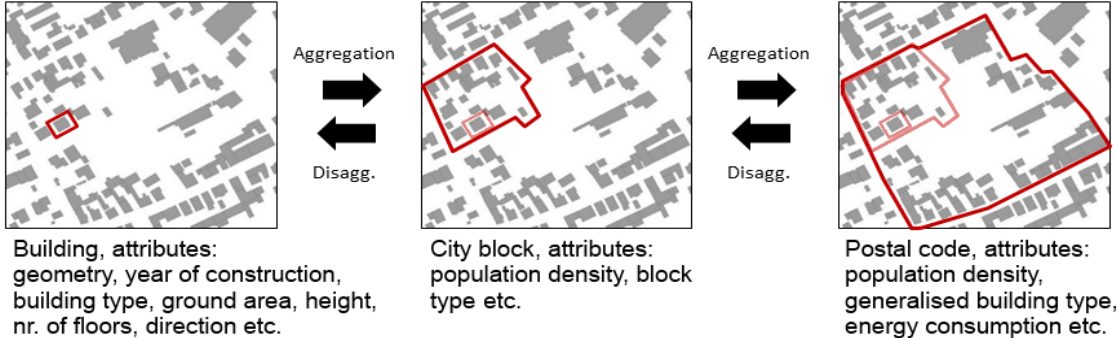
Figure 4. An example of different scales and relevant data when modeling an energy system. The example shows relevant data when simulating the building heat demand at different scales and geospatial